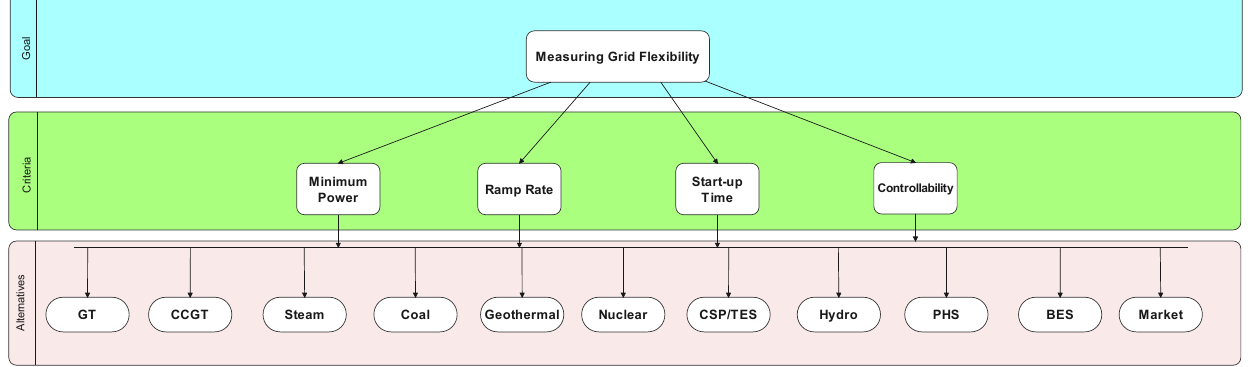
Figure 7. PSF measurement using technical characteristics (GT: gas turbine, CCGT: combined cycle gas turbines, CSP: concentrated solar power storage, TES: thermal energy storage, BES: